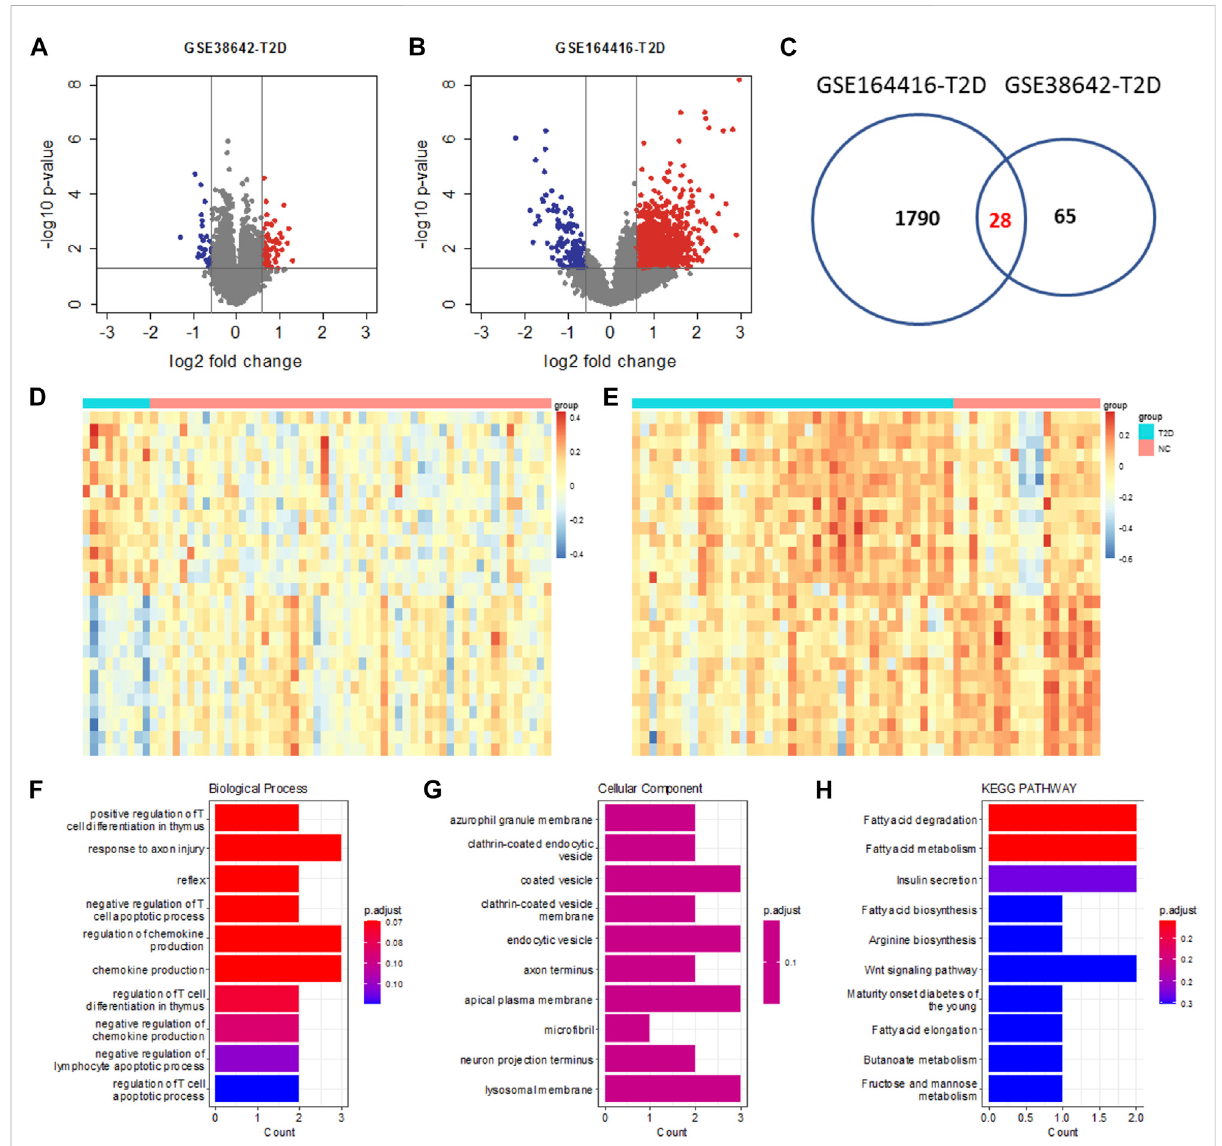
FIGURE 2 Differential analysis of T2DM. Volcano plot of GSE38642 (A) and GSE164416 (B) . The thresholds for the identi fi cation of T2DM DEGs are the same as AD. (C) Venn diagram showing the intersection between DEGs of GSE38642 and GSE164416. Heatmap of expression changes for the common T2DM DEGs in GSE38642 (D) and GSE164416 (E) . (F – H) Functional enrichment analysis of the common T2DM DEGs using Biological Process, Cellular Component and KEGG